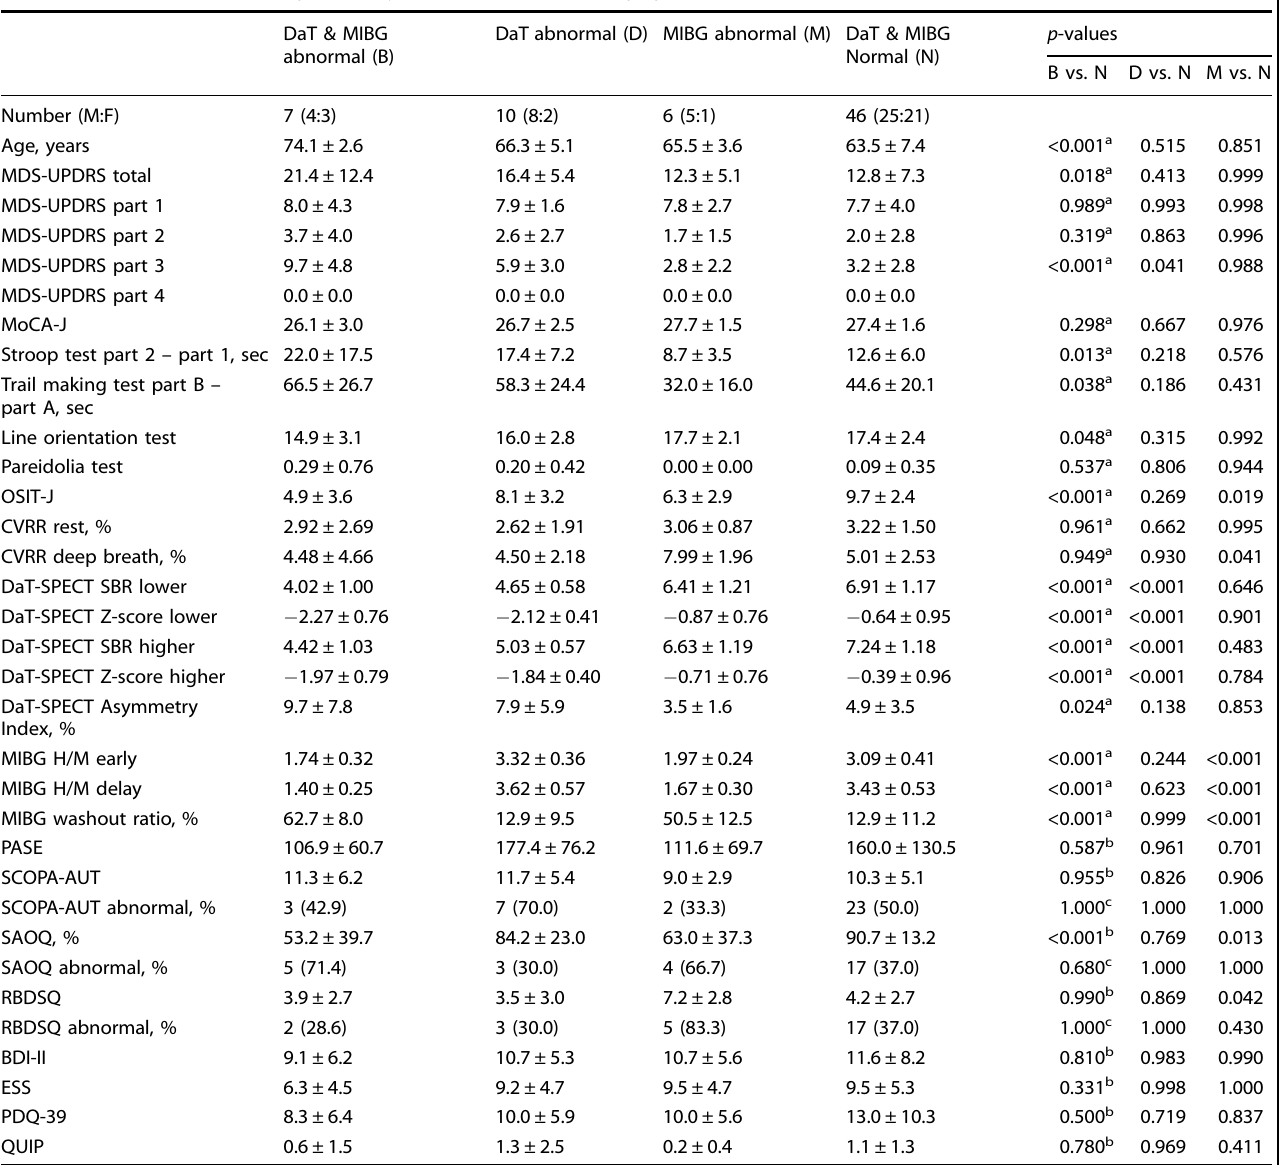
Table 3. Clinical indices of the high-risk subjects with and without imaging